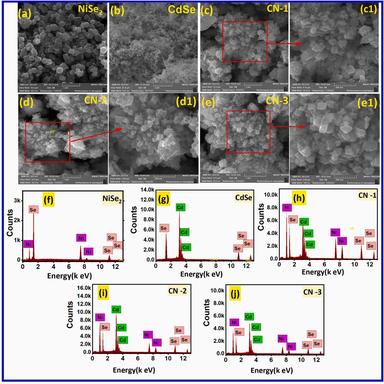
FESEM images of the samples, (a) NiSe2, (b) CdSe, (c, c1) CN-1, (d, d1) CN-2, (e, e1) CN-3 composite. EDX analysis of the samples, (f-j).